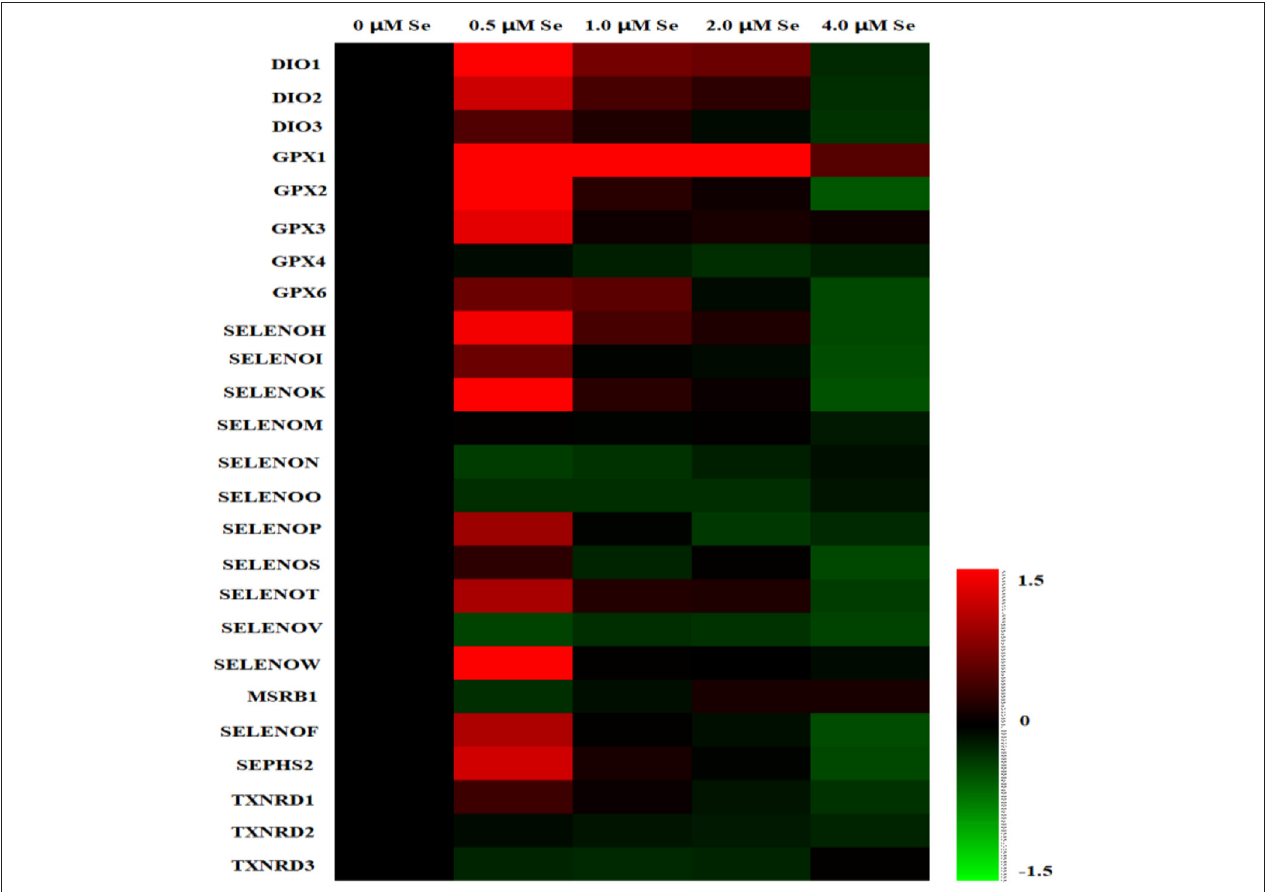
FIGURE 2 | Heat map of the effects of selenomethionine (Se-Met) supplementation on the selenoprotein transcriptome in porcine mammary epithelial cells (pMECs). The cells were incubated for 48h with different concentrations of Se-Met (0, 0.5, 1, 2, and 4 µ M), and then collected for determination of mRNA expression. The heat map displays the extent of the changes. The color scale ranges from saturated red (1.5) to black (0) to saturated green ( − 1.5). Red and green colors represent increased and decreased expressions,